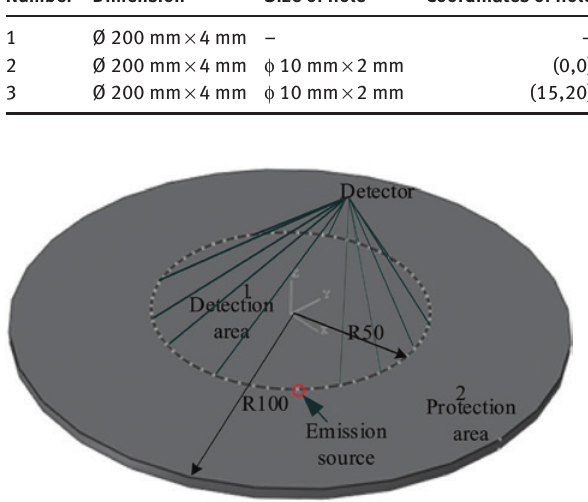
Figure 2: Sensor arrangement and region partition of the models.